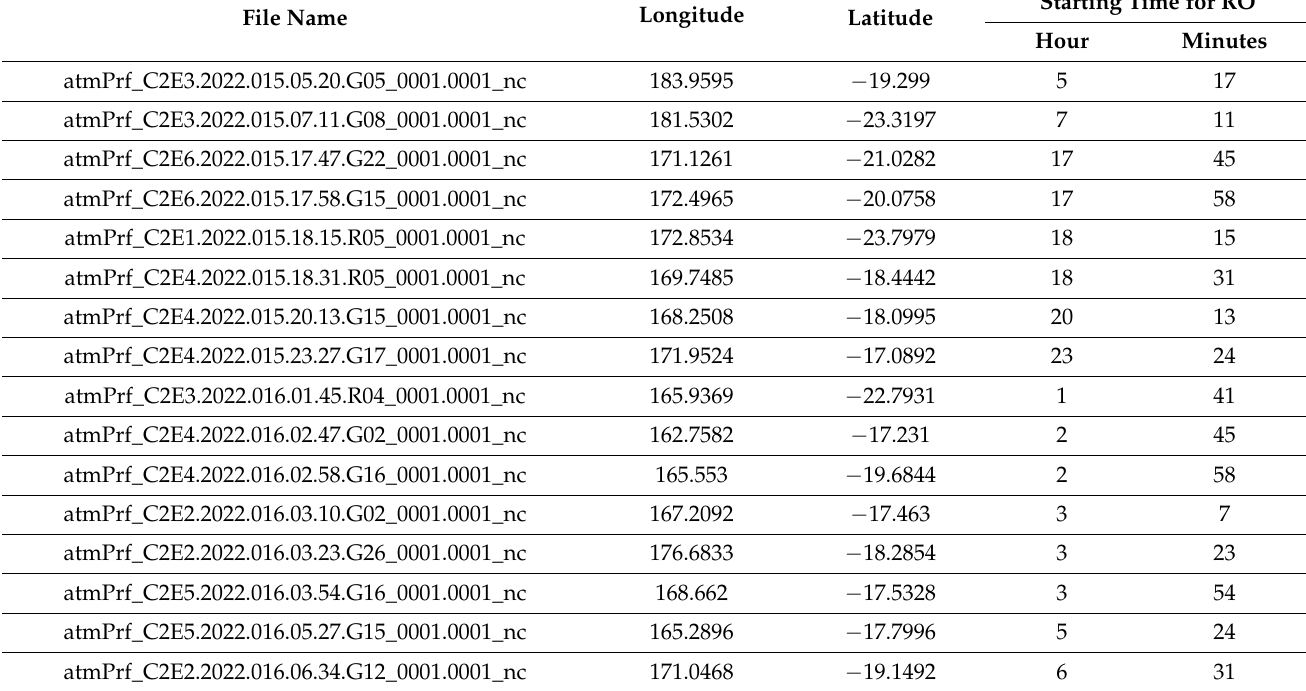
Table 1. Details of collocated COSMIC-2 radio occultation profiles with the volcanic cloud (OMI SO 2 ) on 15 and 16 January. The highlighted file names are related to the RO profiles that were available during the eruptive stage, as shown in Figure